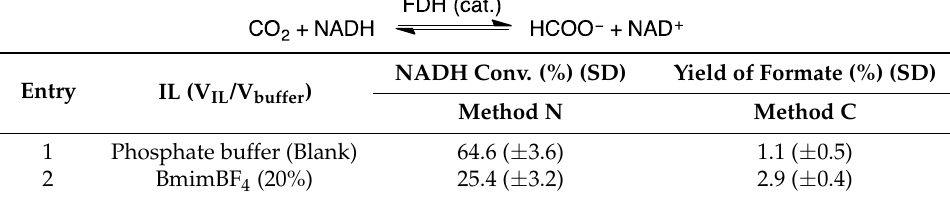
Table 1. Enzymatic Conversion of CO 2 to Formate a .